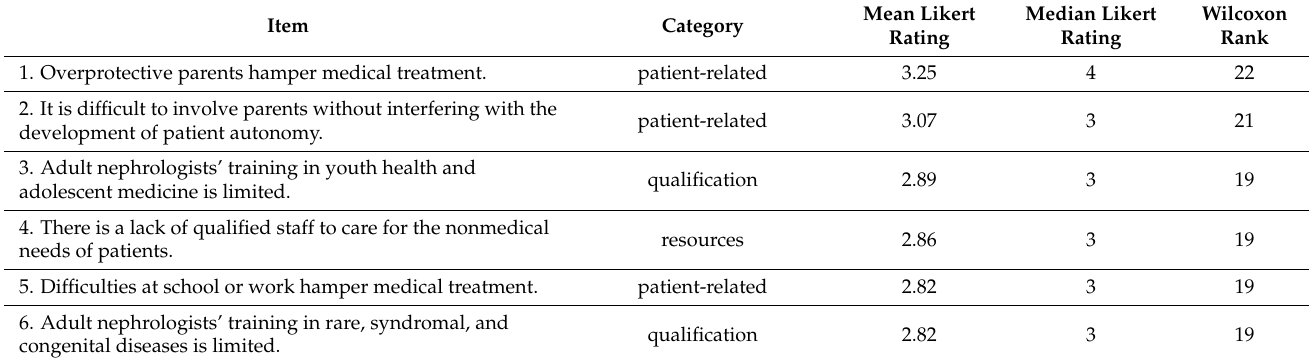
Table 3. Mean and median Likert ratings and Wilcoxon rank order of stage 3 survey items (Bonferroni correction: p < 0.0017, Friedman test p <